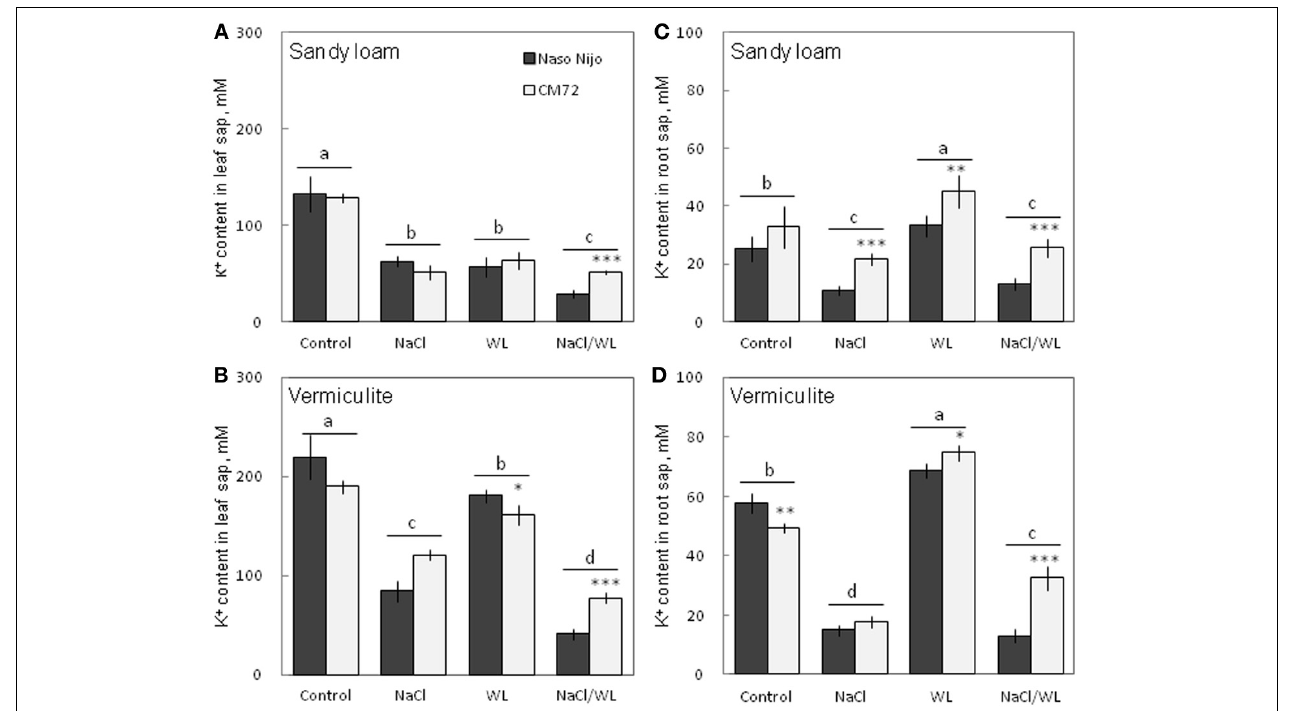
FIGURE 9 | Effects of separate and combined salinity and waterlogging stresses on tissue K + content of two contrasting barley cultivars. (A,B) Soil type effects. Dark bars, Naso Nijo; light bars, CM72. (C,D) Genotype effects. Dark bars, sandy loam; light bars, vermiculite. For growth conditions, details of treatments, and media